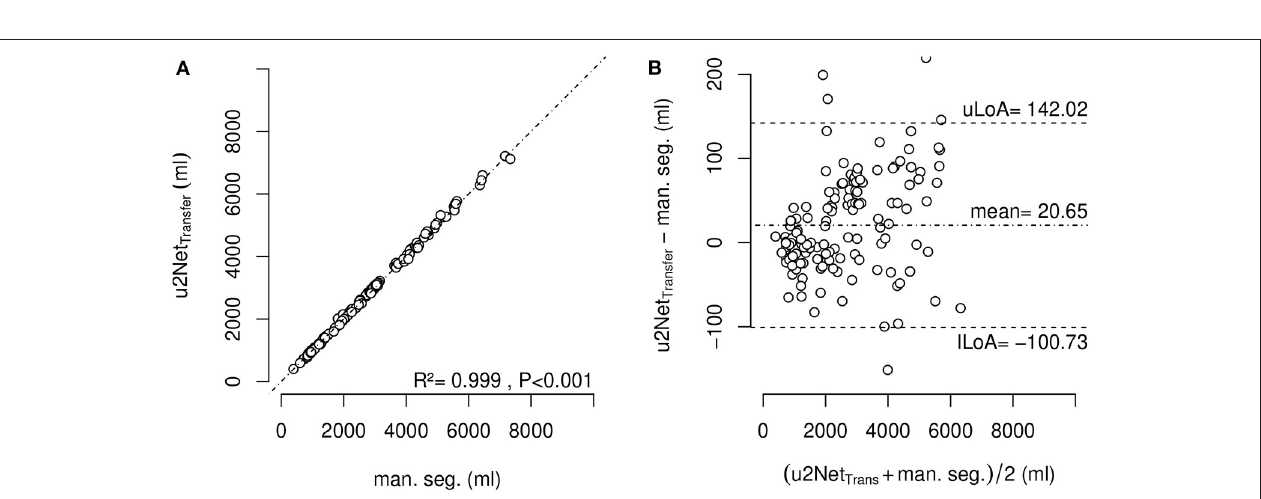
FIGURE 7 | Regression plot (A) and Bland-Altman-analysis (B) of relative non-aerated and poorly aerated lung mass from PEEP = 16 cmH 2 O to PEEP = 8 cmH 2 O in COVID-19 scans using manual segmentation and automatic segmentation from u 2 Net Transfer ; with upper and lower limit of agreement (mean ± 1.96 · standard deviation) uLoA and lLoA ,